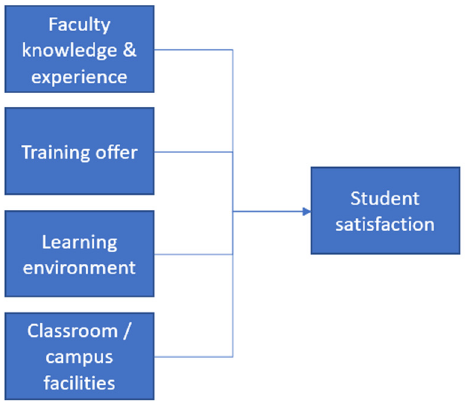
Figure 1. Elements impacting student satisfaction. Source: (Butt and Rehman 2010).